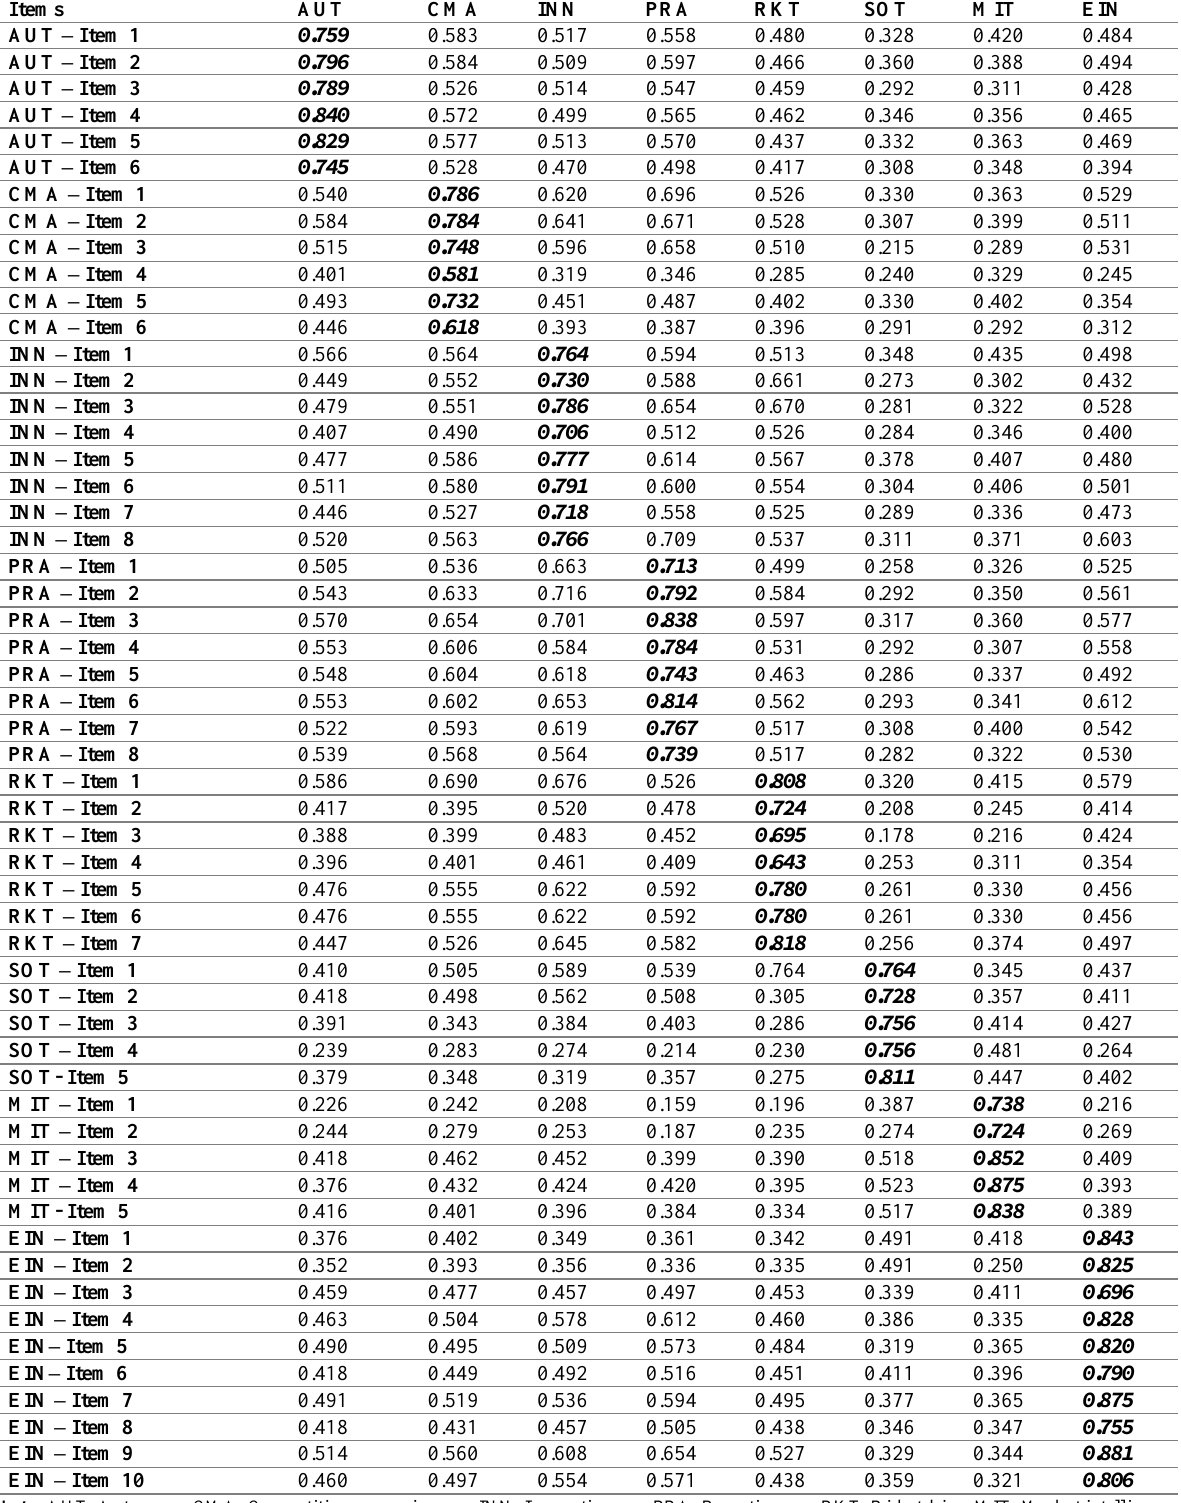
Table 4: Loading and cross-loading (Stage